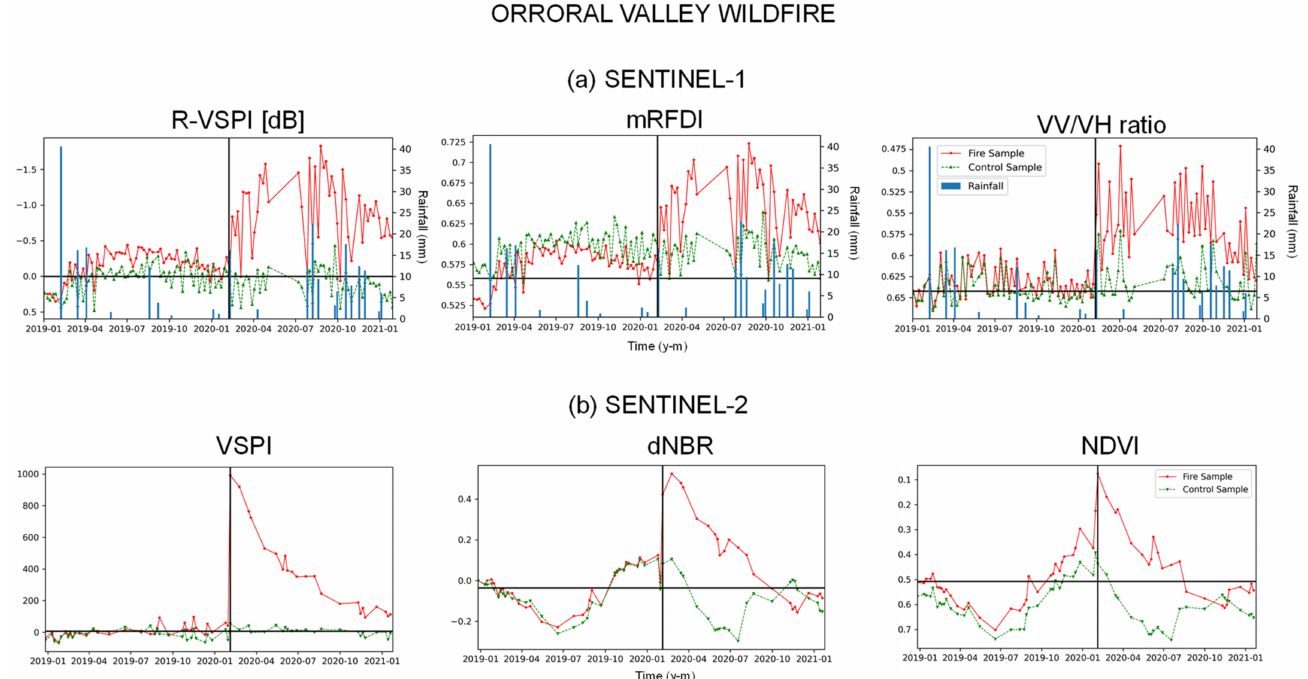
Figure 5. ( a ) Two-year time series of R-VSPI, mRFDI, and VV/VH ratio using Sentinel-1 backscatter dataset for Orroral Valley wildfire (ACT); ( b ) two-year time series of VSPI, dNBR, and NDVI using Sentinel-2 scaled surface reflectance dataset for Orroral Valley wildfire (ACT). Data are shown for burnt/wildfire samples (red) and control samples (green). The black lines indicate the latest imagery post the wildfire event (vertical) and pre-fire conditions (horizontal, mean of the wildfire sample taken pre-fire). The rainfall data is shown in column bars